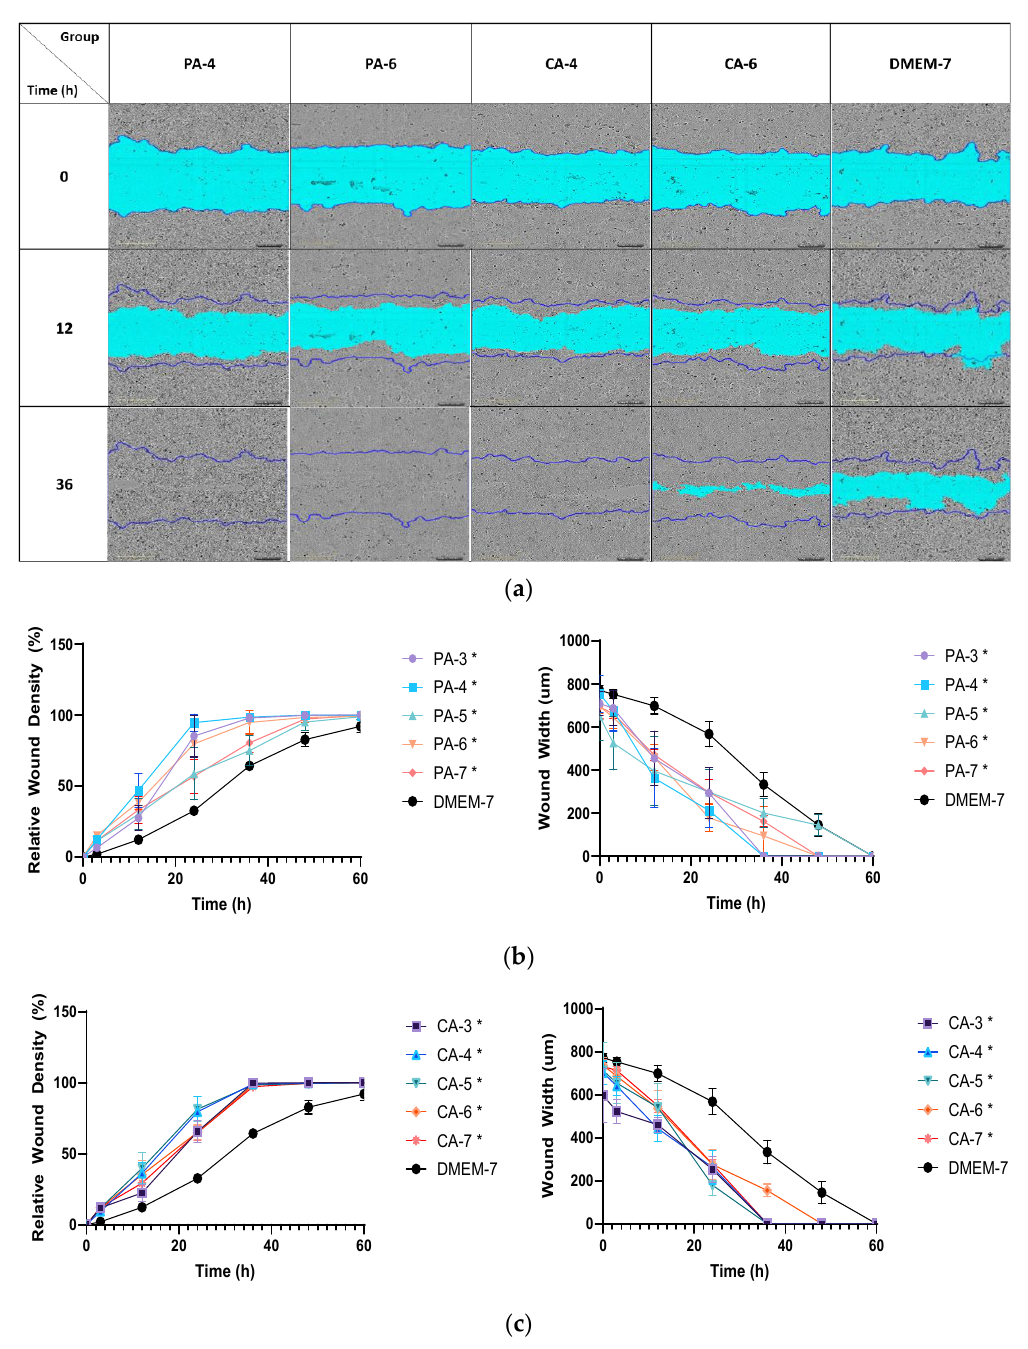
Figure 7. ( a ) Representative contrast images illustrating the migration rate of keratinocyte cells (HaCaT) following acidification treatment regimen C. ( b ) Relative wound density and wound width measured after treatment with 0.01 M phosphoric acid (PA) buffers with pH values of 3, 4, 5, 6 and 7. ( c ) Relative wound density and wound width obtained after incubation with 0.01 M citric acid (CA) buffers. Each error bar represents the mean ± standard deviation. * p < 0.05 indicates that the results obtained were statistically significant from those of the control group (DMEM-7).